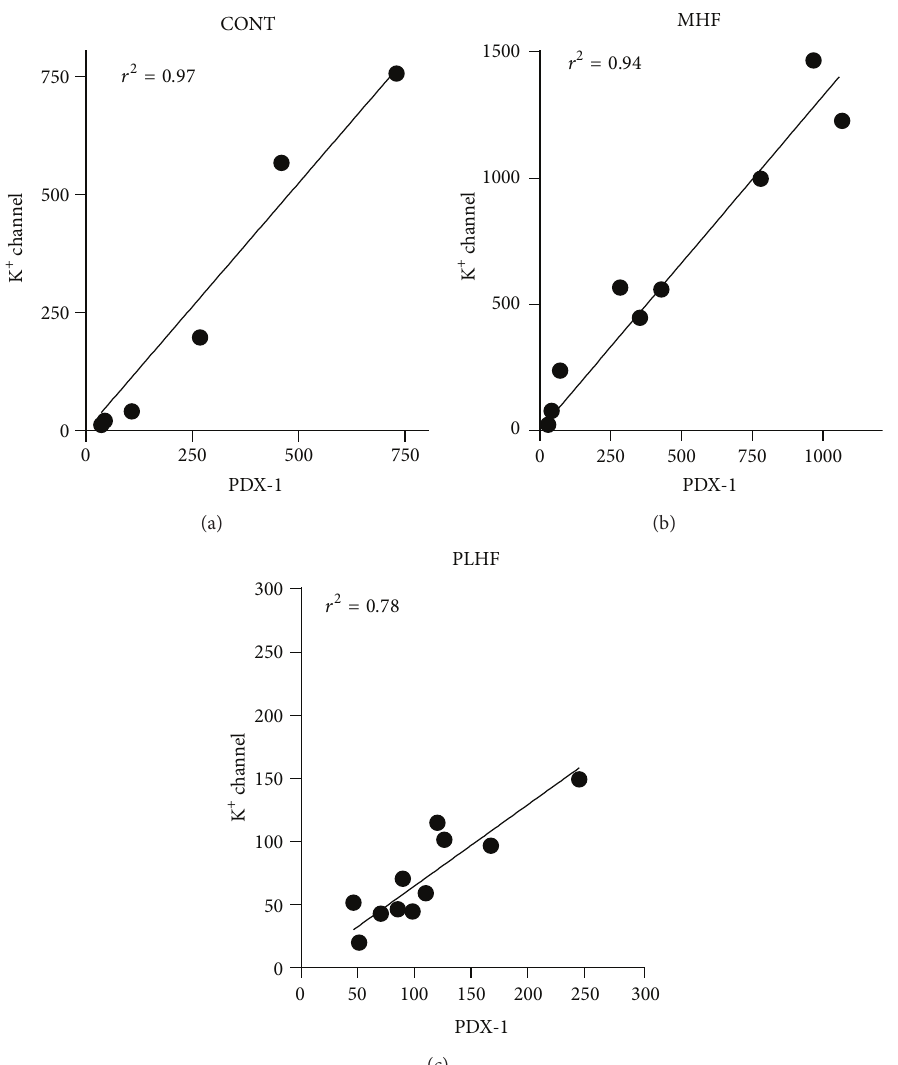
Figure 5: Relationship between PDX-1 and potassium channel subunit Kir6.2 in adult CONT, MHF, and PLHF male offspring. PDX-1, pancreatic, and duodenal homeobox 1. 𝑁 = 8–10 per